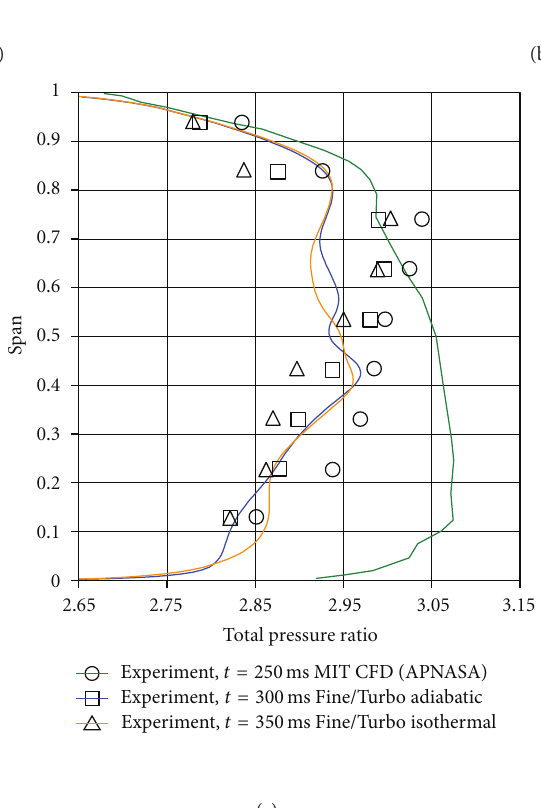
F 10: �pan�ise exit pro�les of e�ciency, total temperature ratio, and total pressure ratio for comparison bet�een the FI���Turbo simulations, MIT simulations and the